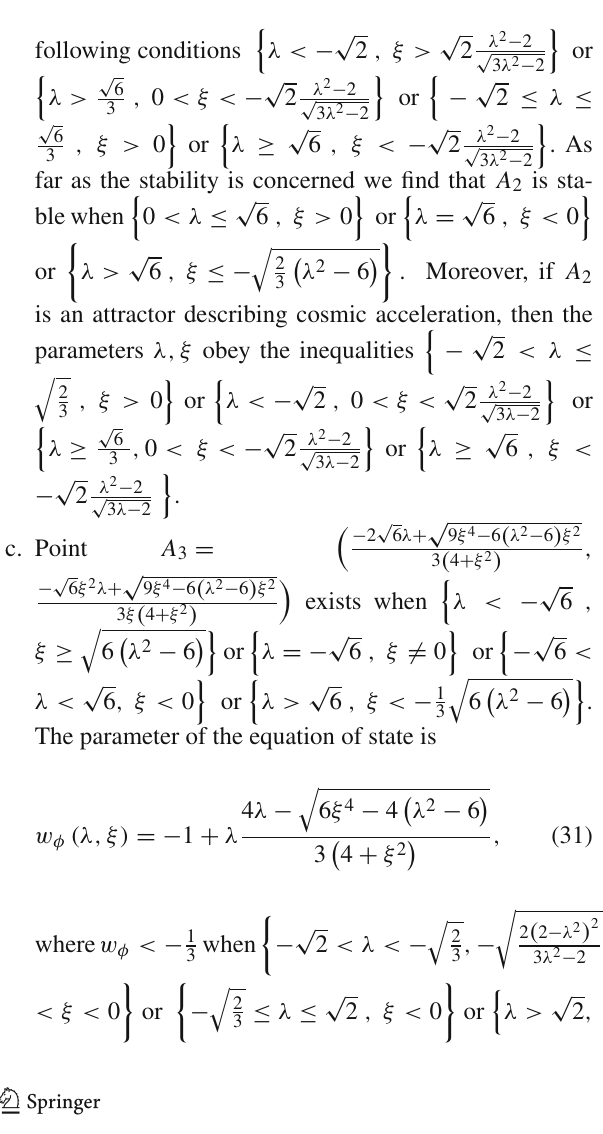
Fig. 1 Region plot in the space { λ,ξ } for w φ in the case of critical points A 2 and A 3 . The stable critical points are represented by shaded regions. Shaded regions define the areas where the critical points are